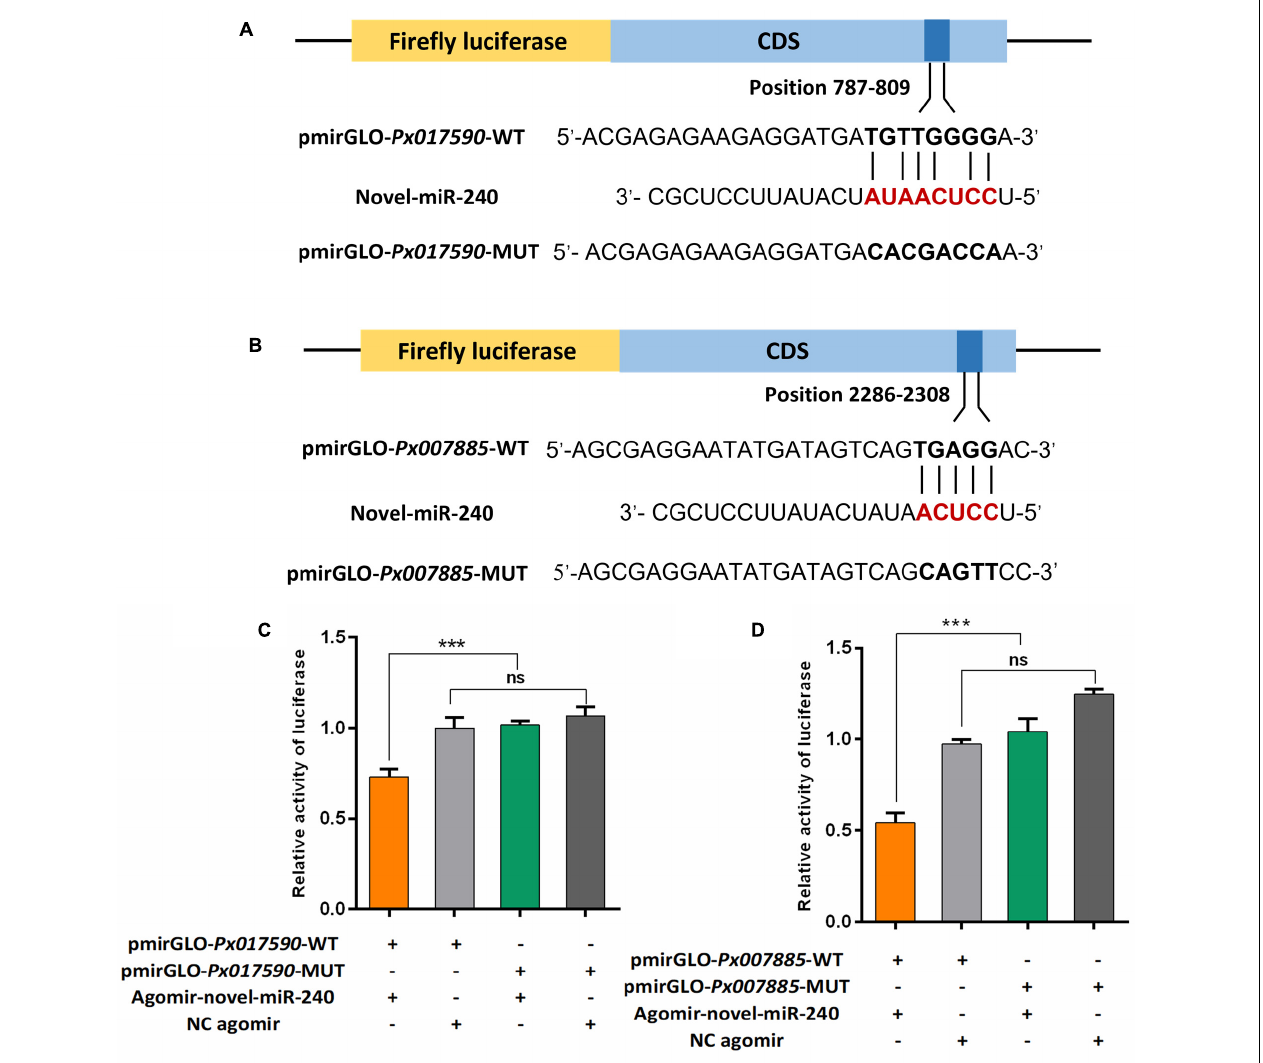
FIGURE 9 | Dual luciferase reporter assay confirmed the interaction between novel-miR-240 and its target genes in vitro. (A) Predicted target sites of novel-miR-240 in the CDS of Px017590 . (B) Predicted target sites of novel-miR-240 in the CDS of Px007885 . WT, wild-type sequence; MUT, mutant sequence. (C) The interaction between novel-miR-240 and Px017590 . (D) The interaction between novel-miR-240 and Px007885 . Statistical significance was analyzed using one-way ANOVA followed by Tukey’s multiple comparisons. The three asterisks indicate p < 0.001 and “ns” represents no significance.